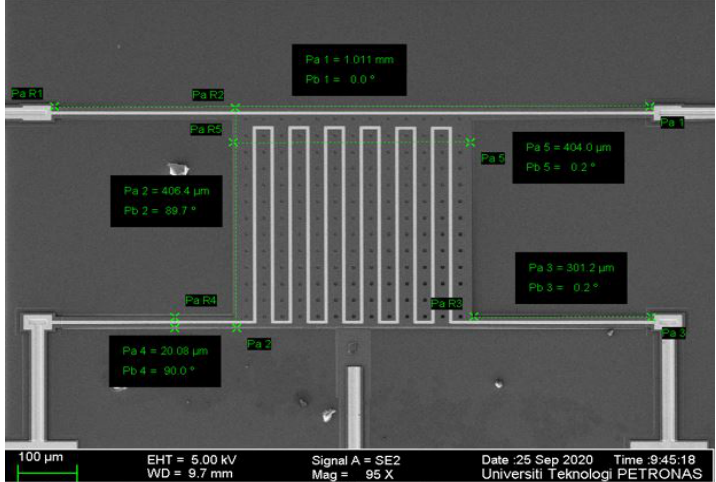
Figure 7. FESEM of the closeup view of the fabricated PolyMUMPs